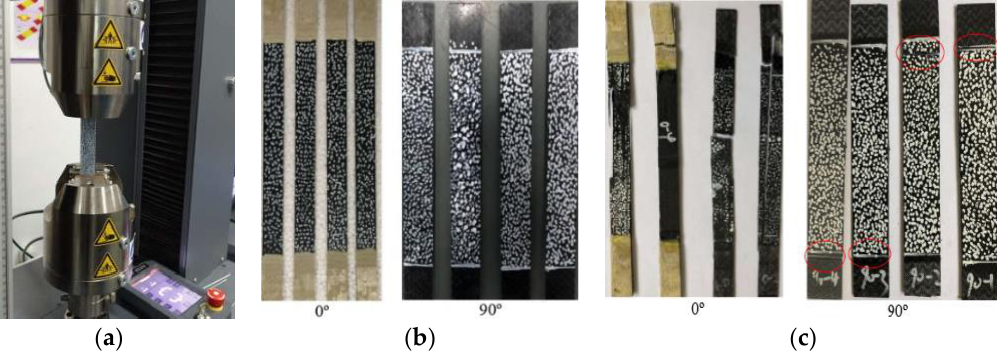
Figure 3. Uniaxial tensile tests at 0° and 90° layer: ( a ) Test machine; ( b ) Uniaxial tensile specimens; ( c ) Failure forms of specimens.